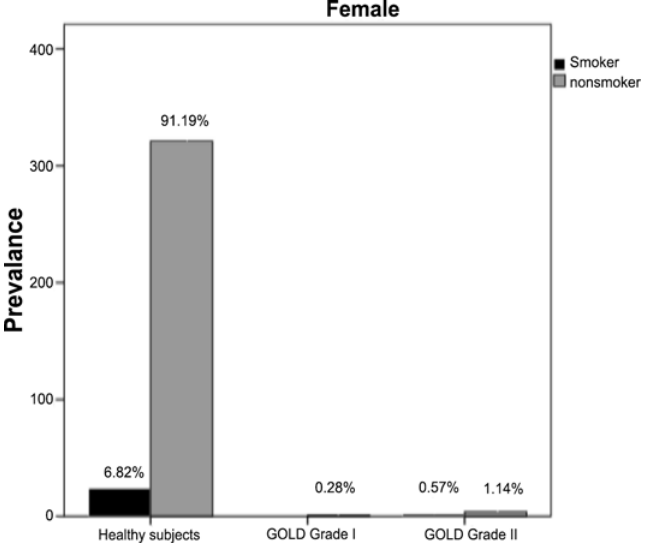
Fig 4. Population characteristics of female smokers and nonsmokers. COPD: Chronic Obstructive Pulmonary Disease; GOLD I: Global Initiative for Chronic Obstructive Lung Disease Grade I COPD; GOLD II: Global Initiative for Chronic Obstructive Lung Disease Grade II